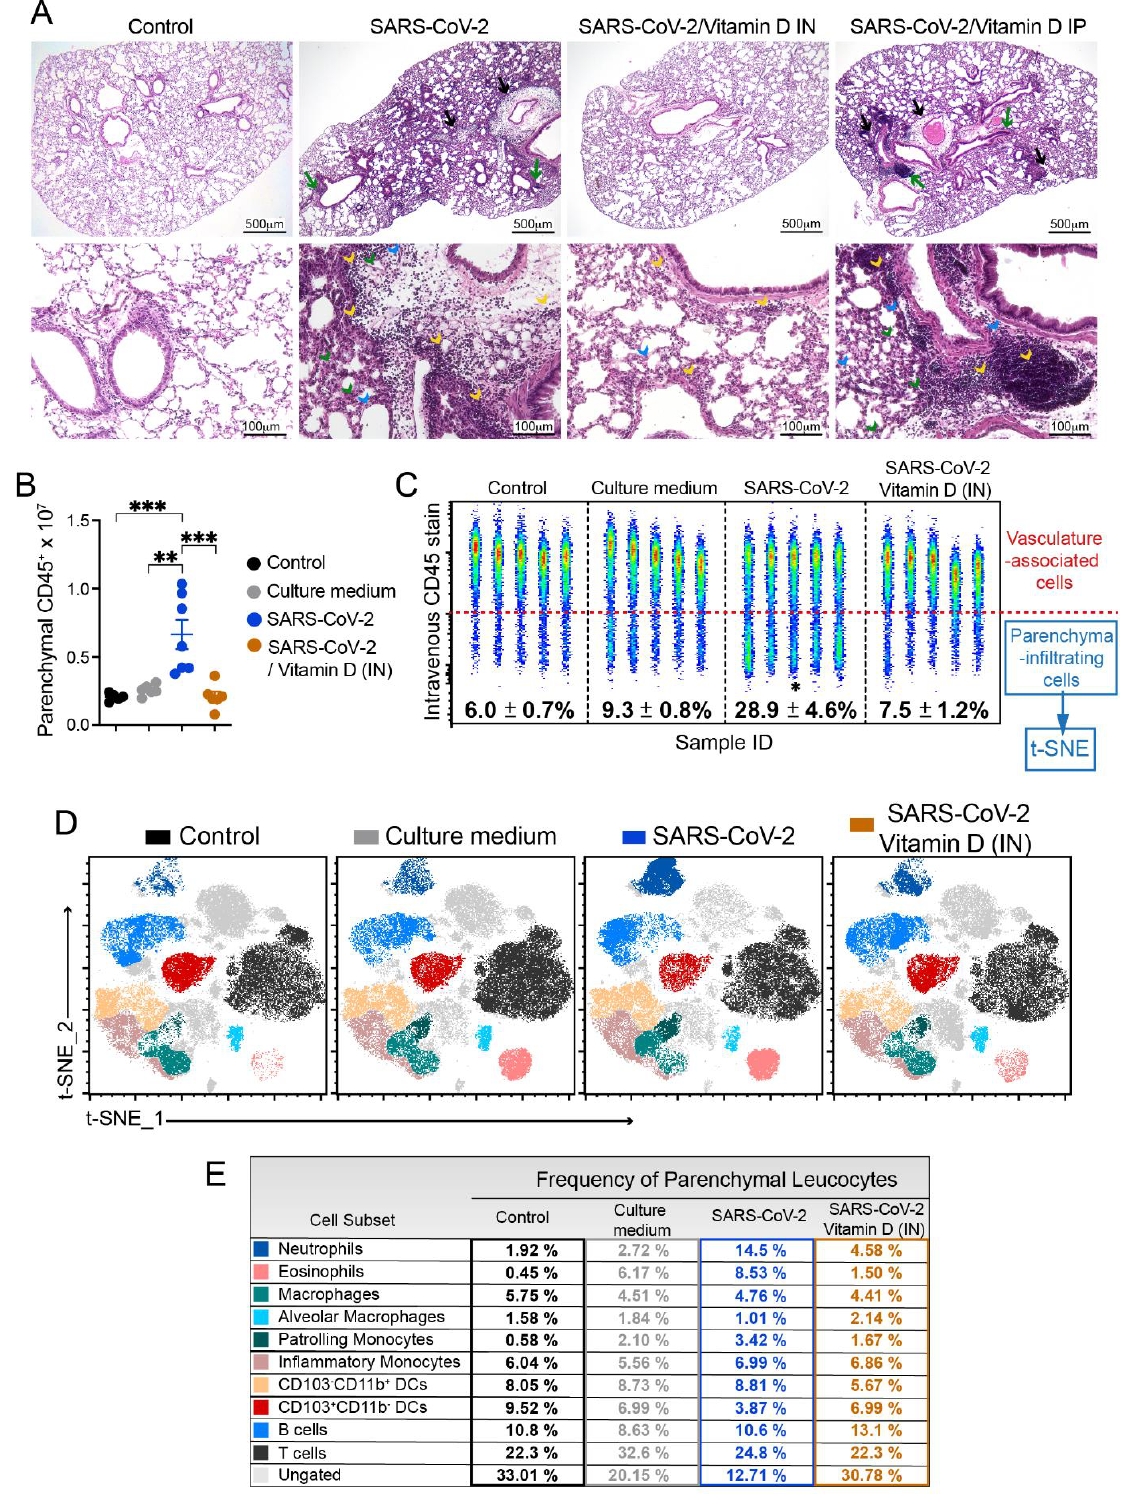
presence of neutrophilic (green arrowhead), macrophage (blue arrowhead), and lympho- but rare in animals treated with VitD through the IN route.